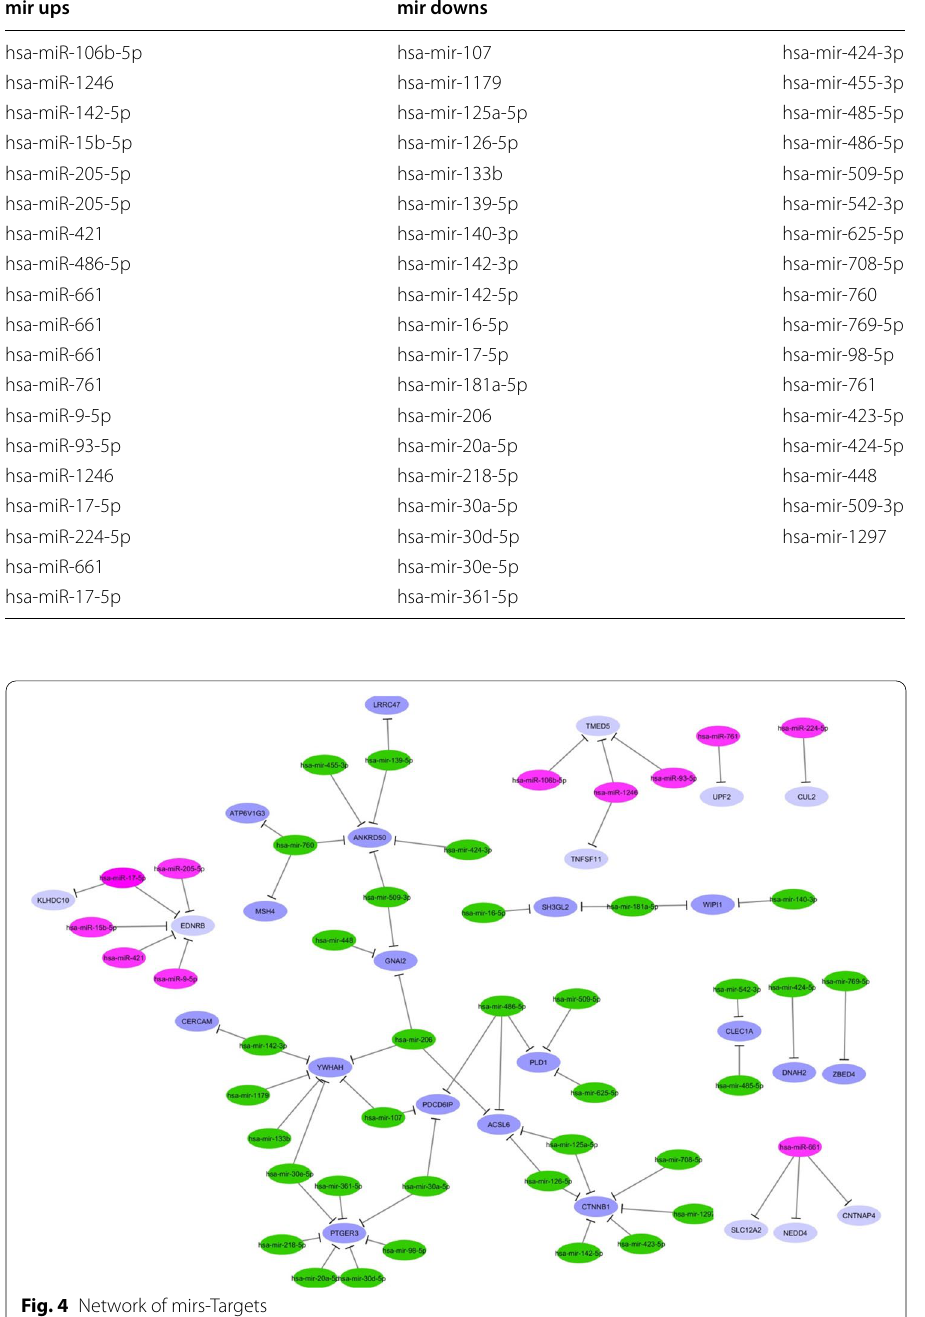
Table 3 mirs related to both upregulated and down regulated genes. In the upregulated genes the mirs are down and in the down regulated genes the mirs are up mir ups